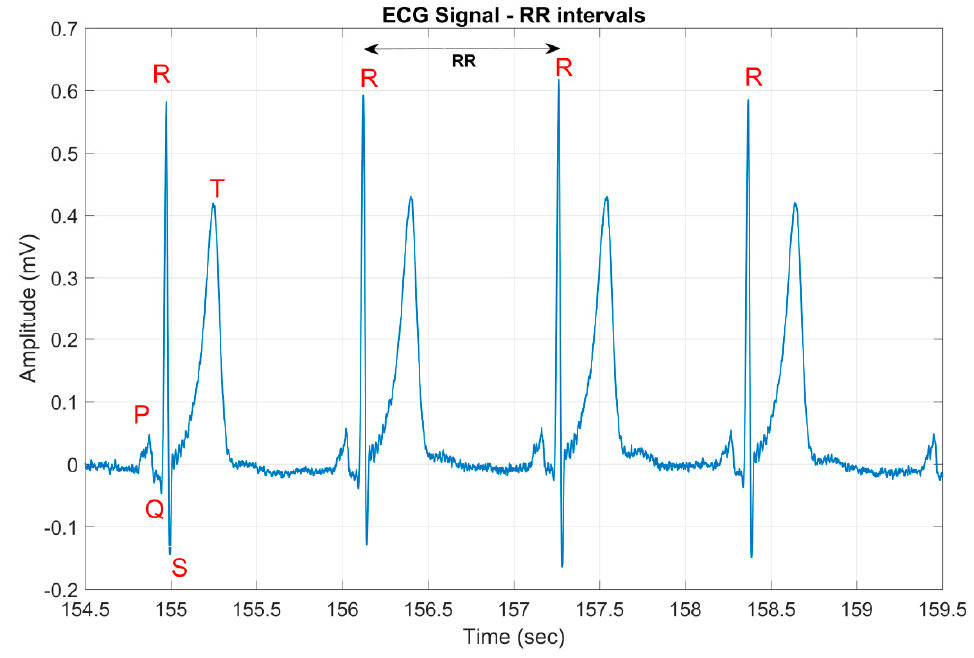
Figure 4. Captured ECG signal (healthy male, 34 years old).